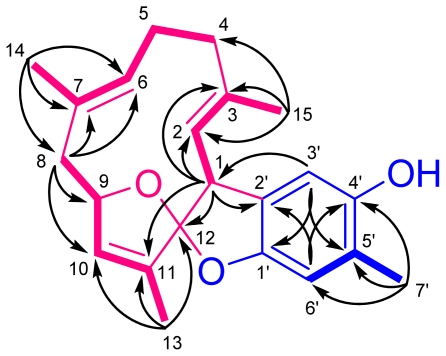
Key 1H–1H COSY (—) and HMBC (→) correlations of 1.